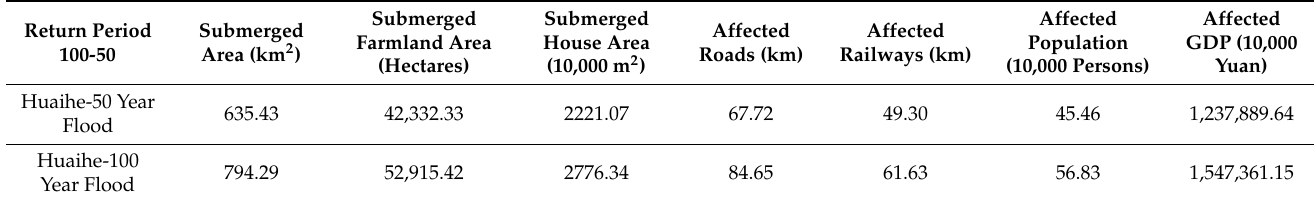
Table 3. Summary of socio-economic losses for 50- and 100-year return periods.